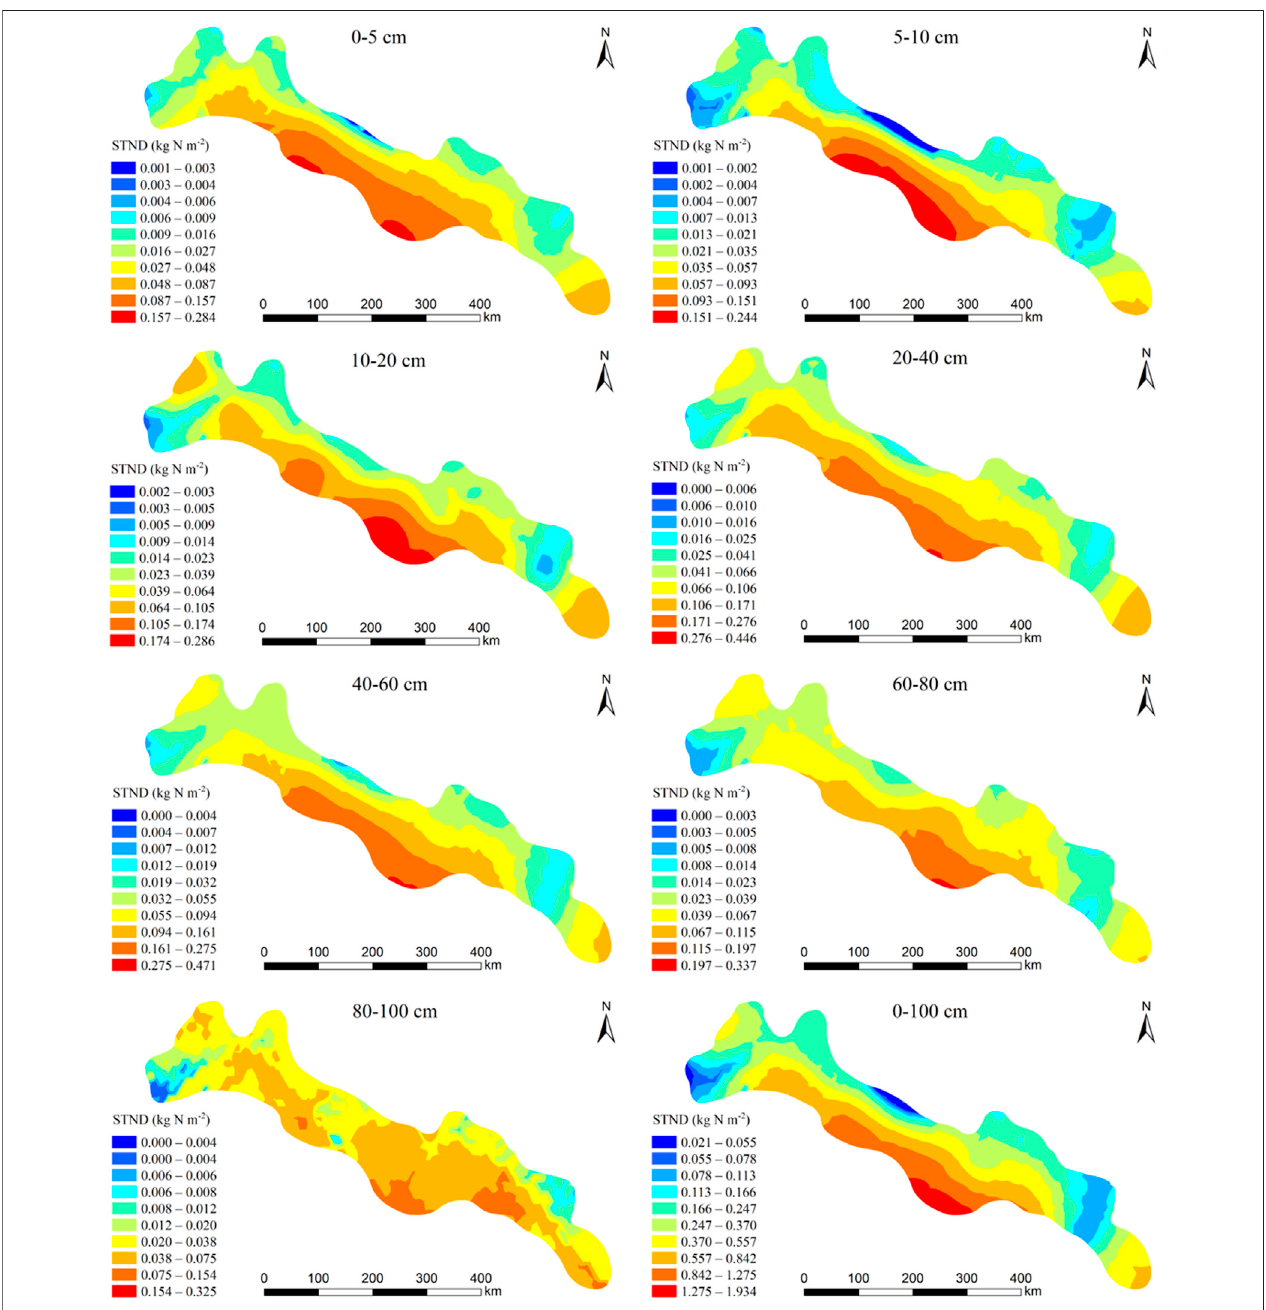
FIGURE 5 | Spatial pattern of soil total nitrogen density ( STND ) for the different soil layers in the desert steppe area of the Hexi Corridor, in northwestern China. Ranges of SOCD were calculated using the natural breaks method.